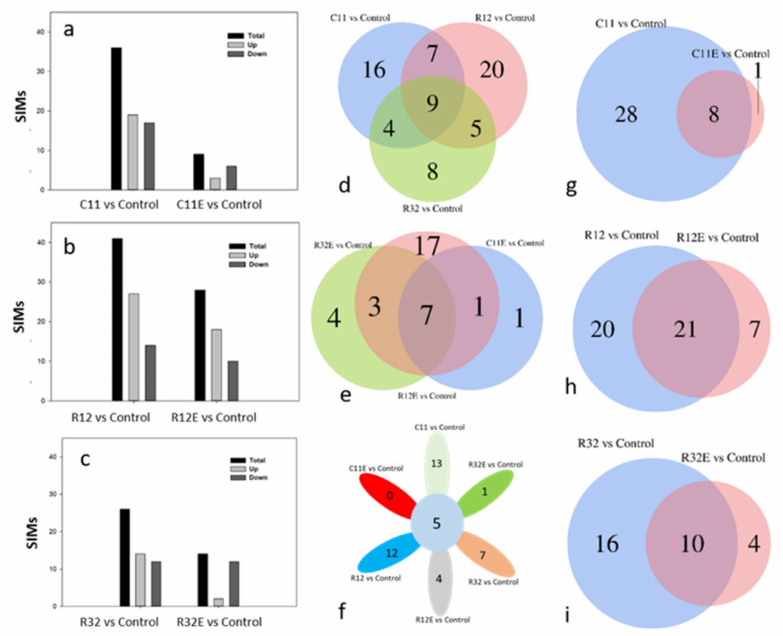
Figure 3. Comparing the number of significantly influenced metabolites (SIMs) initiated in endo- phytic fungi- and fungal extract-exposed grape cells. Bar plots ( a – c ) display the number of SIMs triggered in different EF- and CFE-exposed grape cells. The Venn plots ( d – i ) show the number of specific or co-initiated SIMs between or among different treatments. C11, R12, R32, C11E, R12E, and R32E briefly represent the sample groups treated with the corresponding endophytic fungal strains or their derived fungal extracts. Table 1. The significantly influenced metabolites (SIMs) detected in grape cells exposed to endophytic fungi and fungal